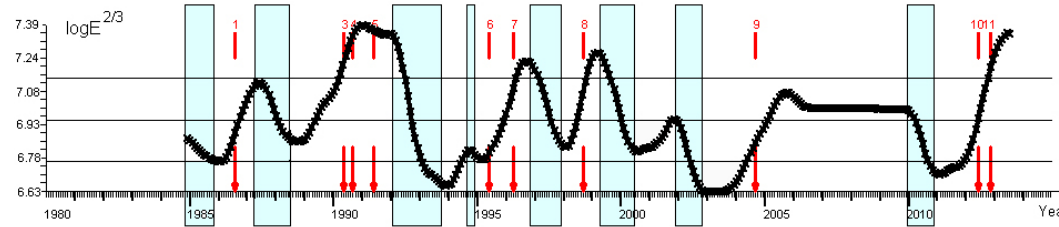
Figure 5. Temporal variation of log E 2 / 3 . Numbered arrows perpendicular to the time axis denote the origin time of all strong earthquakes, with magnitude M L ≥ 4.0. Solid rectangle shows the low probability periods for an earthquake occurrence which is followed by the consec- utive high probability periods.